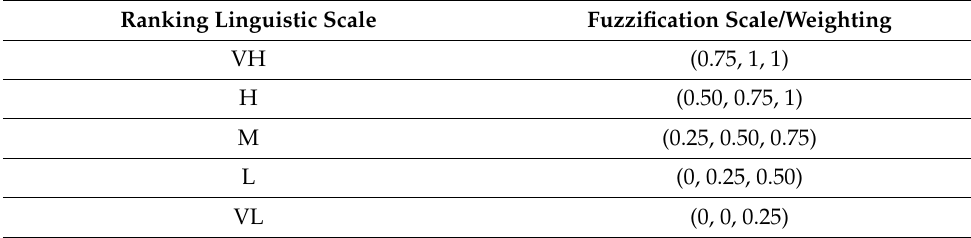
Table 1. Linguistic fuzzy scale.